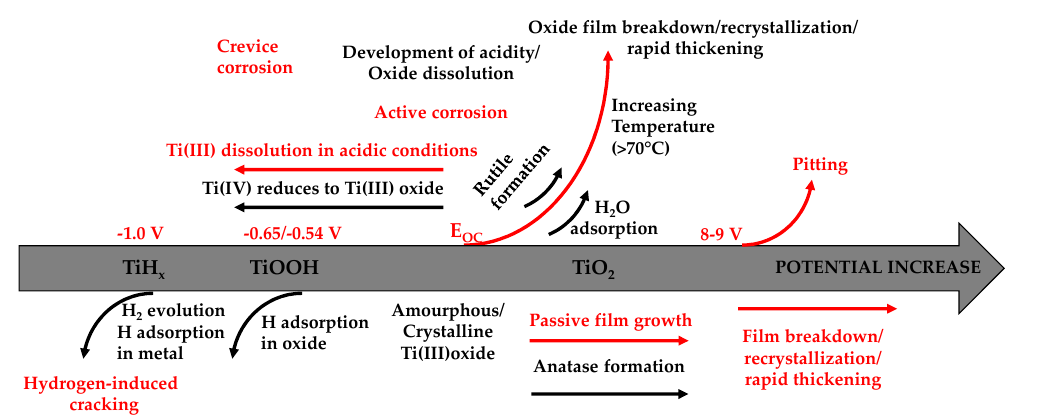
Figure 6. Scheme showing the properties of the passive film on titanium as a function of potential and temperature. E OC = open circuit potential. Adapted from [54], copyright (2017), with permis- sion from Elsevier.